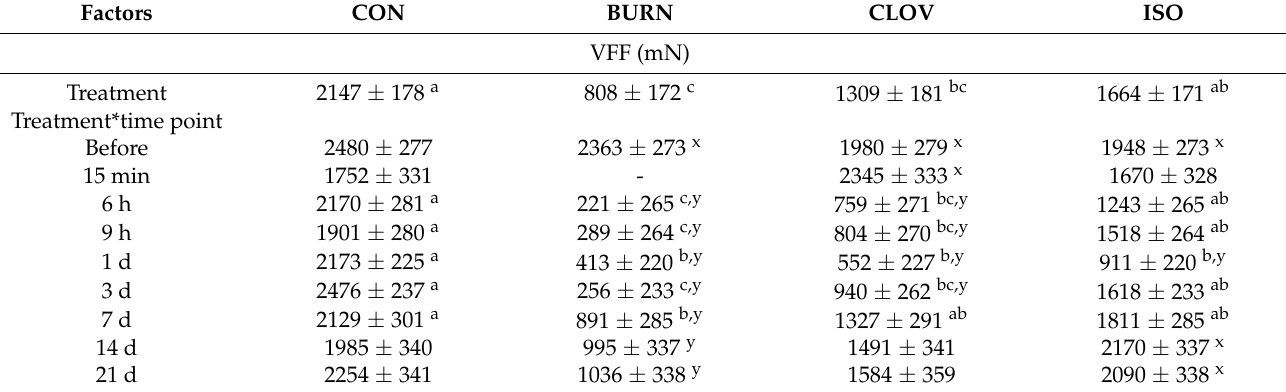
Figure 3. Mechanical nociceptive threshold (MNT) measured with von Frey filaments (applied force in mN, ( a ), logarithmic scale) or a pressure algometer (applied force in N, ( b )) in the four different treatments—injection of saline (CON), clove oil (CLOV), isoeugenol (ISO) or disbudding with a hot iron (BURN). The boxplots represent the mean MNT across the different locations of measurement at different time points. No measurement exists for BURN at 15 min due to sedation. The box-and- whisker-plots show the median (line in box), 25 and 75% quartile (bottom and top end of the box) and minimum and maximum (whiskers) except for outliers (circles, distance to box 1.5–3 times the interquartile range) and extreme values (asterisks, distance to box > 3 times the interquartile range). Table 1. Mechanical nociceptive threshold measured with von Frey filaments (vFF) or a pressure algometer (PA) for the four treatments—injection of saline (CON), clove oil (CLOV) or isoeugenol (ISO) and hot-iron disbudding (BURN). Data are presented over all time points (treatment) or for each time point, i.e., before treatment or the indicated minutes, hours or days after treatment depicted by the interaction treatment*time point. Values show estimated means ± standard error of the force applied. n = 10